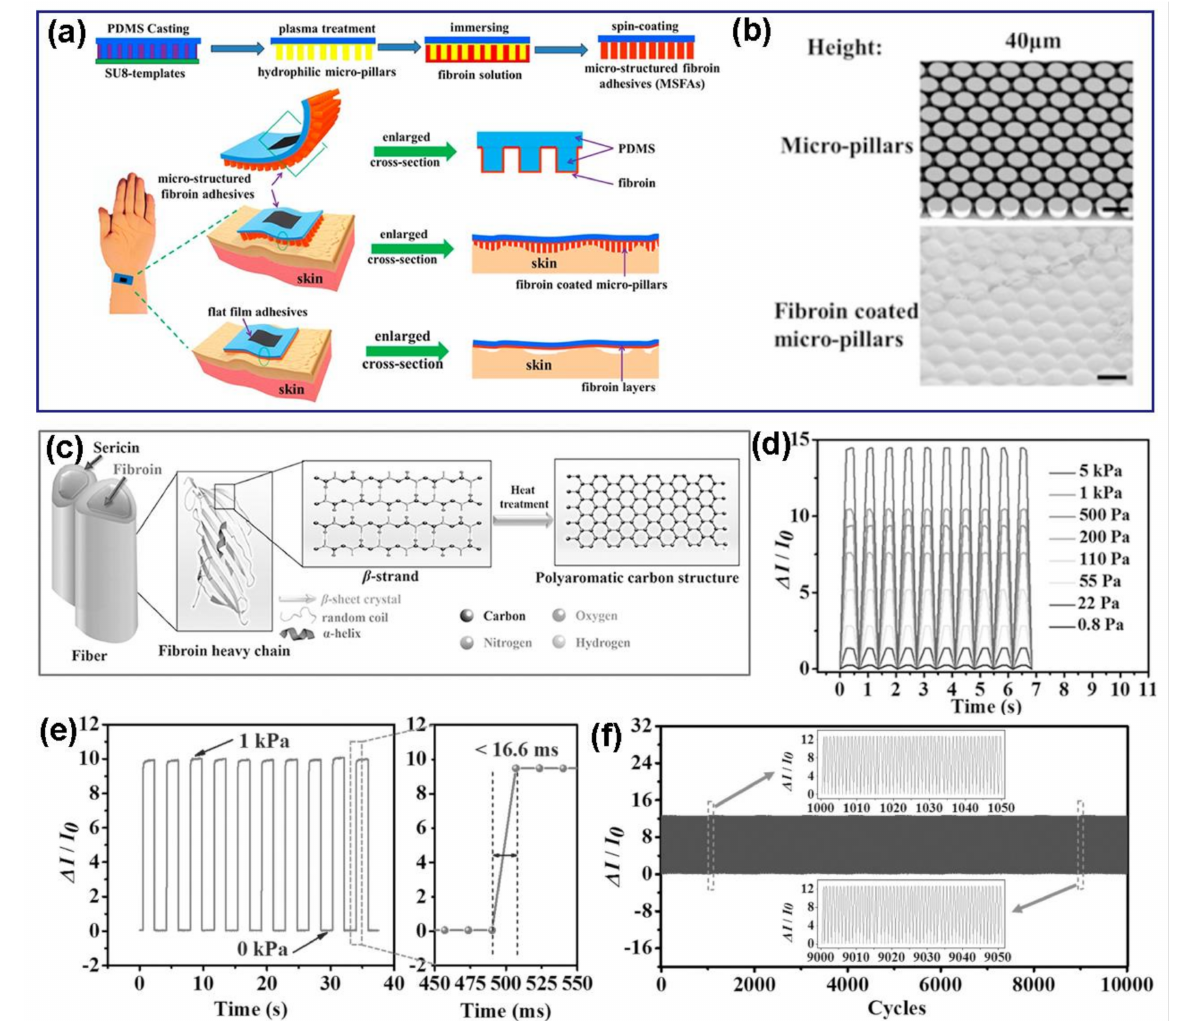
Figure 4. ( a ) Fabrication process of microstructured fibroin adhesive (MSFA) and the schematic of an MSFA on the skin of the wrist, ( b ) scanning electron microscopy (SEM) images of bare (top) and fibroin (bottom) coated micropillars with a diameter of 80 µ m and heights of 40 µ m. Reproduced with permission from [58]. Copyright 2020, American Chemical Society; ( c ) the schematic illustration structure of pristine silk and carbonized silk, ( d ) multiple cycles of pressure response under 10 Pa–5 kPa, ( e ) the pressure response at high frequency and the response time within 16.6 ms, ( f ) the durability test of the pressure sensor over 10,000 loading-unloading cycles at a frequency of 0.5 Hz under an applied pressure of 2.5 kPa. Reproduced with permission from [59]. Copyright 2017,